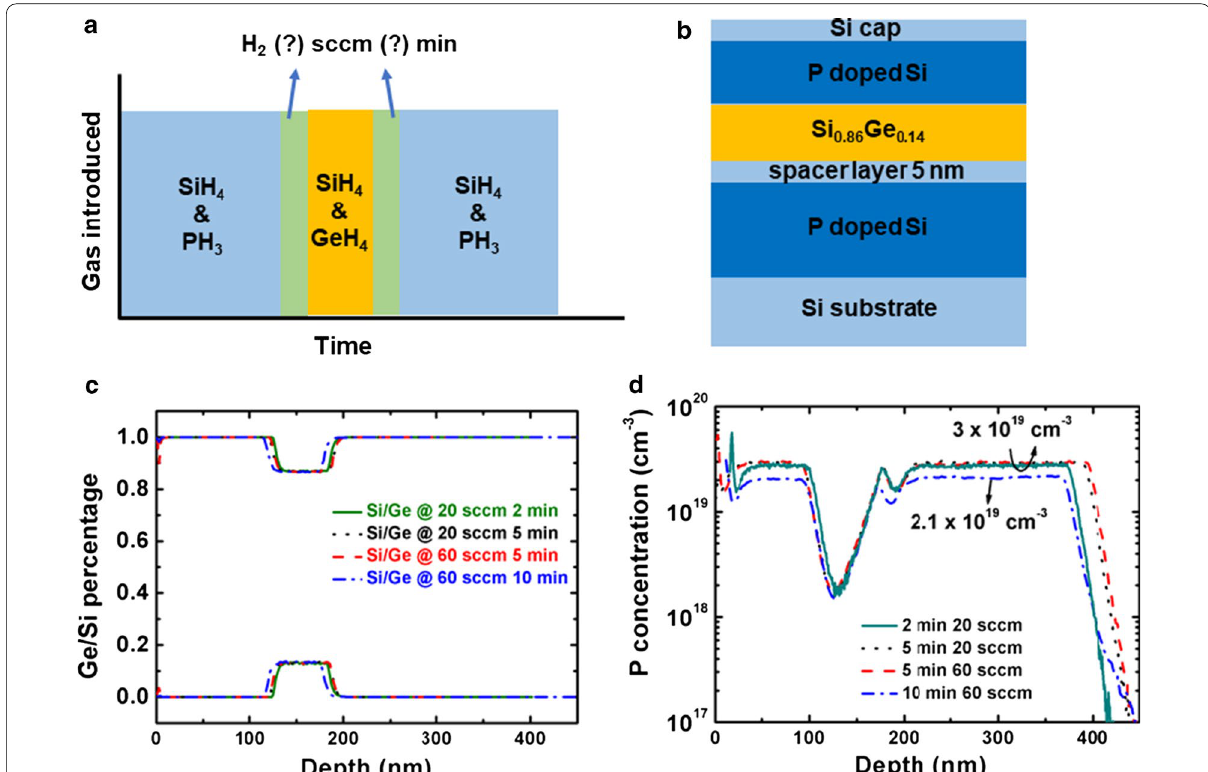
Fig. 3 Schematic diagrams of a doping strategy of H 2 purge conditions, and b experimental structure of Si/SiGe/Si MLs. c Ge/Si profile and d P concentration of P-doped